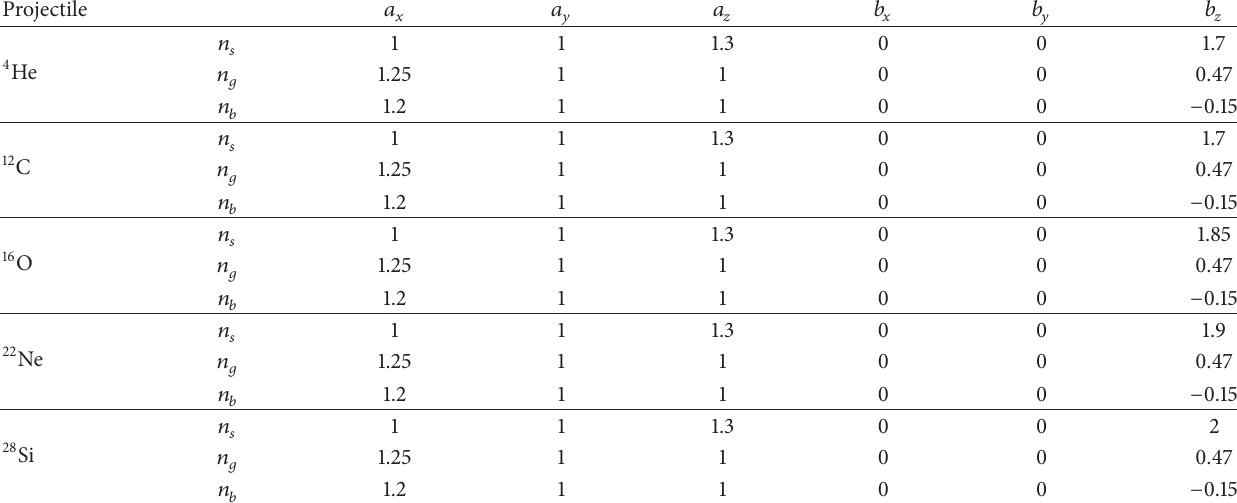
Table 7: Parameter values for angular distributions for shower, grey, and black particles. The values of 𝑎 𝑥 , 𝑎 𝑦 , and 𝑎 𝑧 and 𝑏 𝑥 , 𝑏 𝑦 , and 𝑏 𝑧 for 4 He-, 12 C-, 16 O-, and 28 Si-Em at 4.5 AGeV/c and 22 Ne-Em at 4.1 AGeV/c.